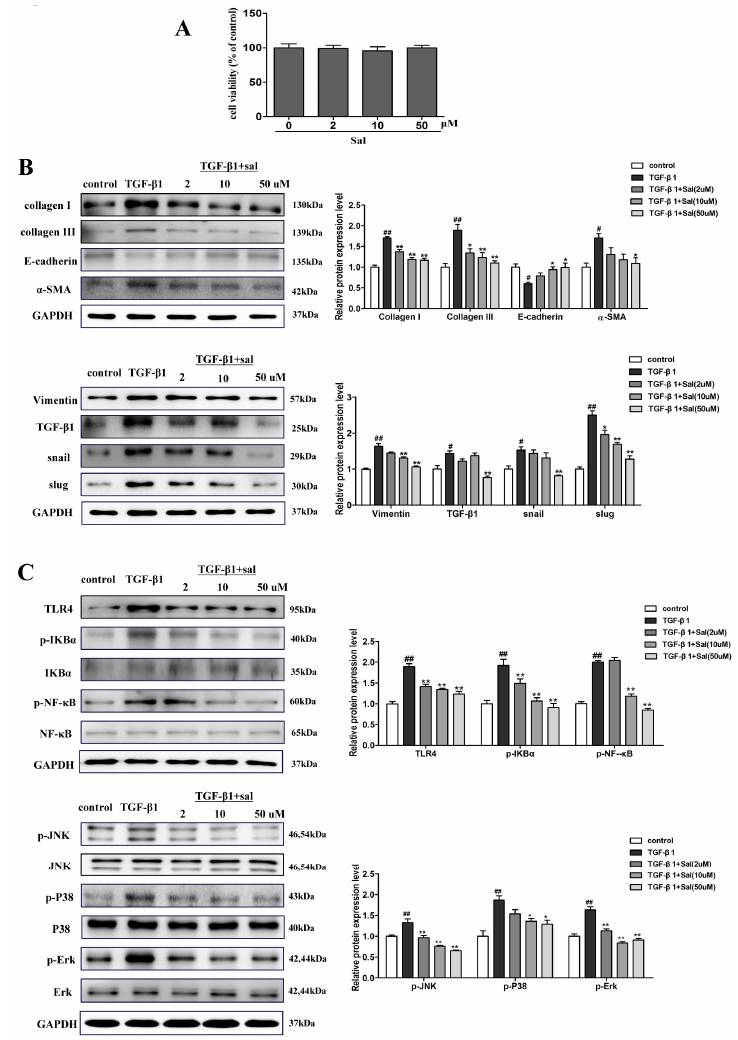
Figure 6. Sal inhibited TGF- β 1-induced HK-2 cells ECM deposition, EMT and inflammatory response via the TLR4/NF- κ B and MAPK signaling pathways. ( A ) Effect of different doses of salidroside on HK-2 cell viability. HK-2 cells (1 × 10 4 cells/well) were exposed to a series concentration of salidroside (0, 2, 10, 50 µ M) for 24 h. The viability of HK-2 cells was assessed by a cell counting kit-8 (CCK-8) assay. ( B ) Western blotting was performed to determine the protein expression levels of collagen I, collagen III, α -SMA, vimentin, E-cadherin, TGF- β 1, snail, and slug in TGF- β 1-induced HK-2 cells. The cell was incubated with different concentrations of Sal (2, 10, 50 µ M), followed by stimulation with 5 ng/mL of TGF- β 1 for 48 h. ( C ) Sal inhibited the expression of TLR4, p-I κ B α , p-NF- κ B, p-P38, p-ERK, and p-JNK in TGF- β 1-induced HK-2 cells. The cell was incubated with different concentrations of salidroside (2, 10, 50 µ M), followed by stimulation with 5 ng/mL of TGF- β 1 for 48 h. All data are expressed as mean ± SD, # P < 0.05, ## P < 0.01 vs. control group, * P < 0.05, ** P < 0.01 vs. TGF- β 1 group.